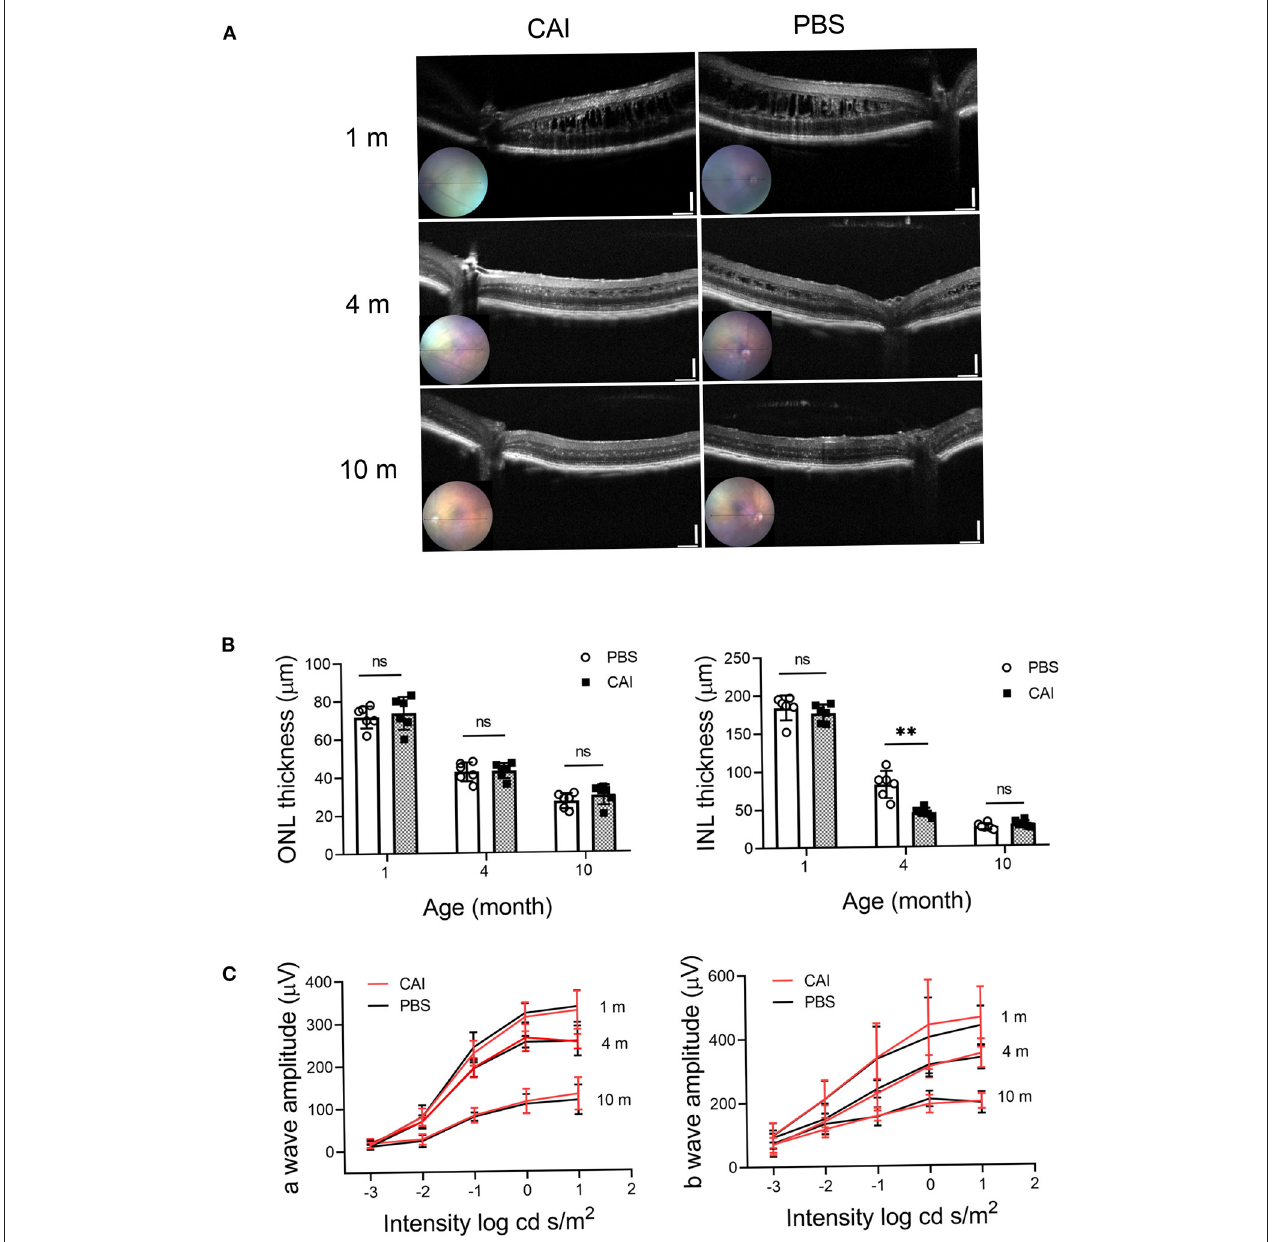
FIGURE 9 | Structural and functional changes after CAI treatment in Rs1 − / Y mice retina were evaluated by OCT and ERG. (A) Retinal images obtained from OCT in living animals were used to evaluate the retinal morphology at 3 different ages. From 1 month, the left eyes of Rs1 − / Y mice were treated with brinzolamide eye drops (10 mg/ml) for 3 continuous months, the contralateral eyes were treated with PBS as control. OCT were performed at 1, 4, 10 months of age. (B) ONL and INL thickness were measured from 200 to 1,200 µ m inferior and superior to the optic nerve ( n = 6 at each time point). (C) Functional changes by CAI treatment in Rs1 − / Y mice retina were evaluated by ERG. The CAI treated eyes were compared with the control eyes using Student’s t -test: ***, P < 0.001. CAI, carbonic anhydrase inhibitor; OCT, optical coherence